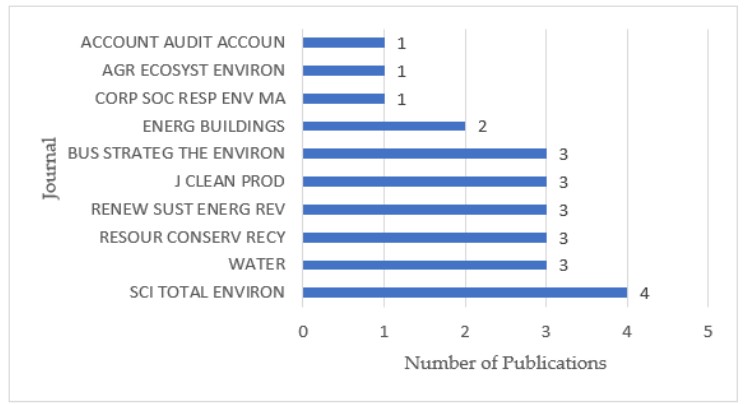
Figure 4. Journal distribution .